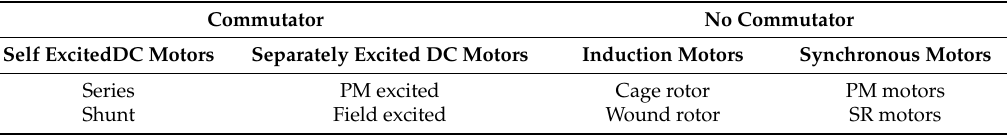
Table 11. Electric Motors